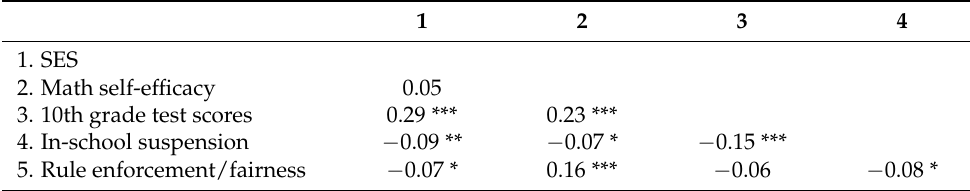
Table 3. Pearson correlations between student-level fixed effects.